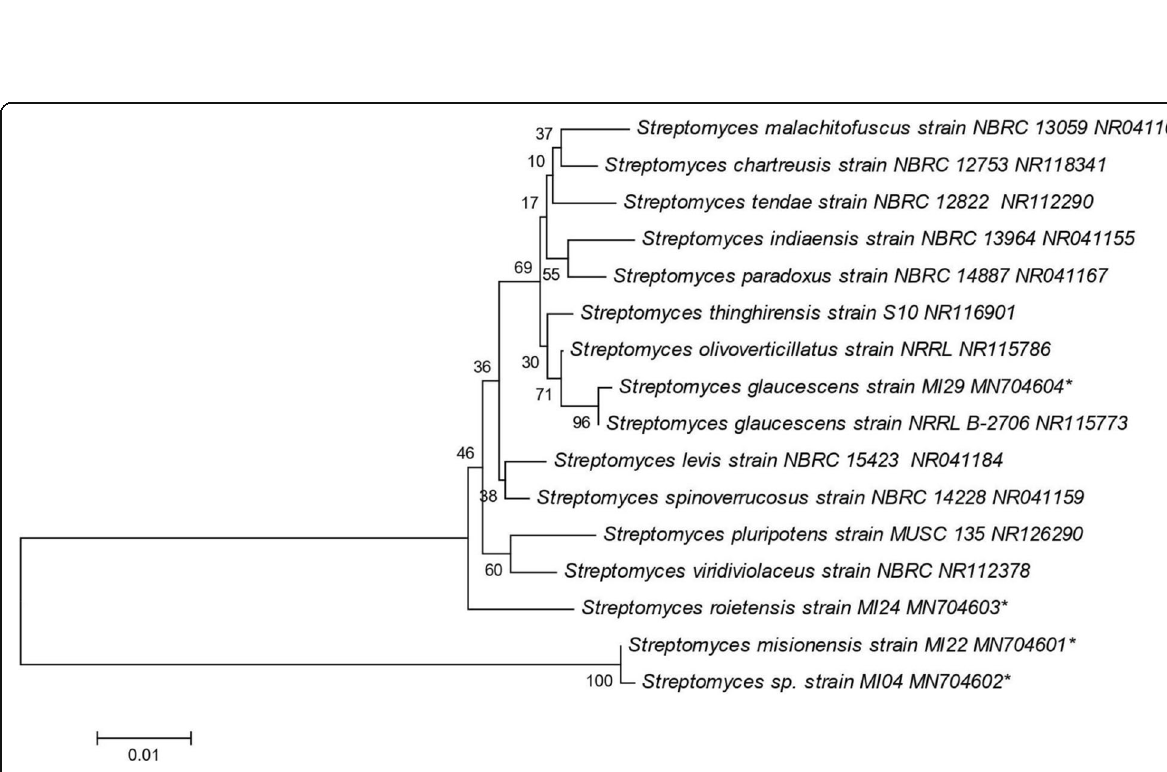
Fig. 3 Phylogenetic tree retrieved from neighbor-joining analysis showing the evolutionary relationship of Streptomyces misionensis MI22, Streptomyces sp.MI04, Streptomyces roietensis MI24, and Streptomyces glaucescens MI29 with its closest BLAST hits. Bootstrap values (1000 replications) based on multiple sequence alignment using the MEGA software